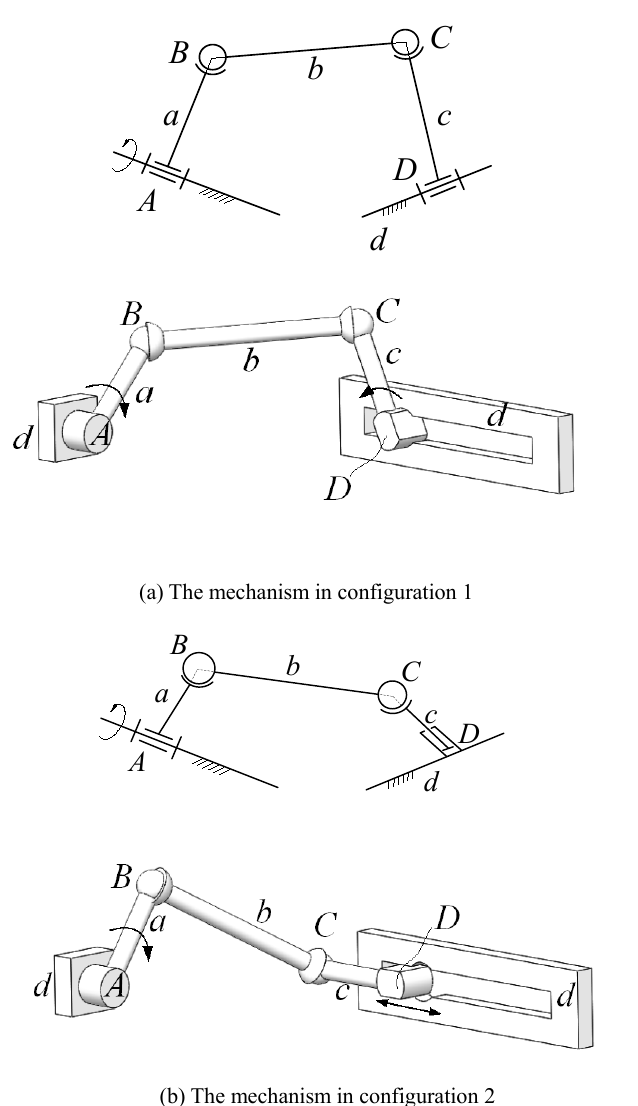
Figure 4. A four-bar spatial metamorphic mechanism.